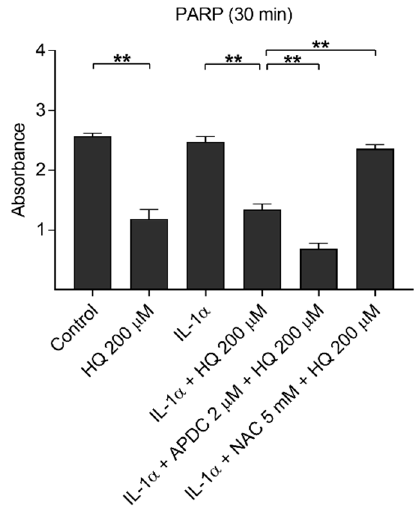
Figure 10. The effect of 200 µ M hydroquinone (HQ) on the intracellular PARP level with and without IL-1 α -priming and antioxidants (2 µ M APDC, 5 mM NAC) in ARPE-19 cells. IL-1 α and untreated control group were used as the control for hydroquinone treatment. Data were collected from two independent experiments containing three parallel samples per group. Results are shown as mean ± SEM. ** P < 0.01, Mann-Whitney U-test. [Kruskal-Wallis test, *** P < 0.001].